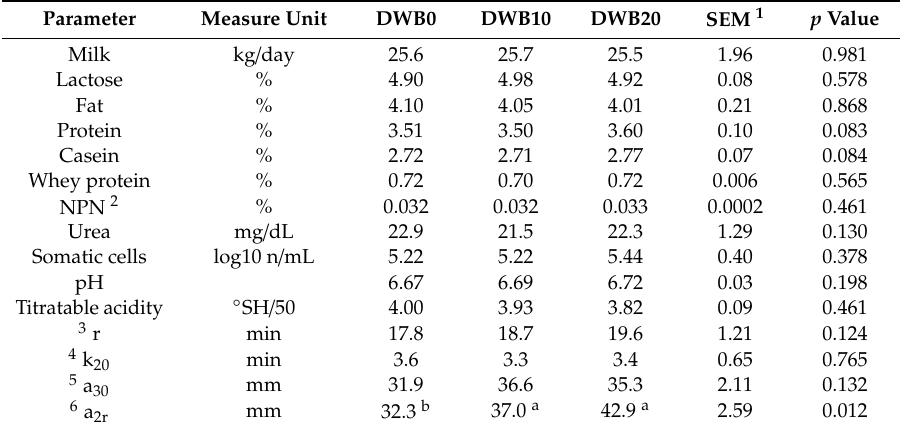
Table 5. E ff ect of feeding regime on milk composition traits and coagulation properties.